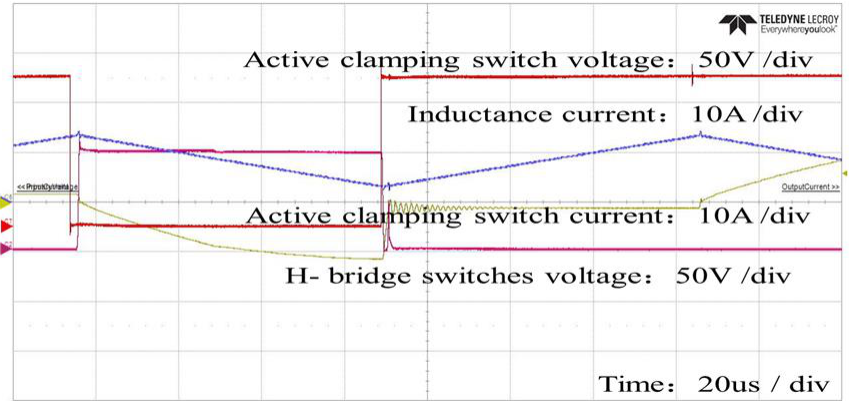
Figure 15. Active clamping switch ZVS process of DC/DC module.